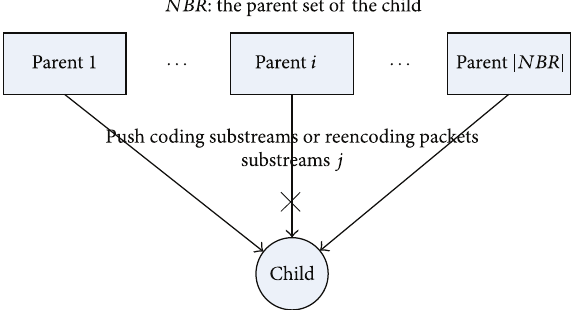
Figure 2: The scheduling process of a child and its